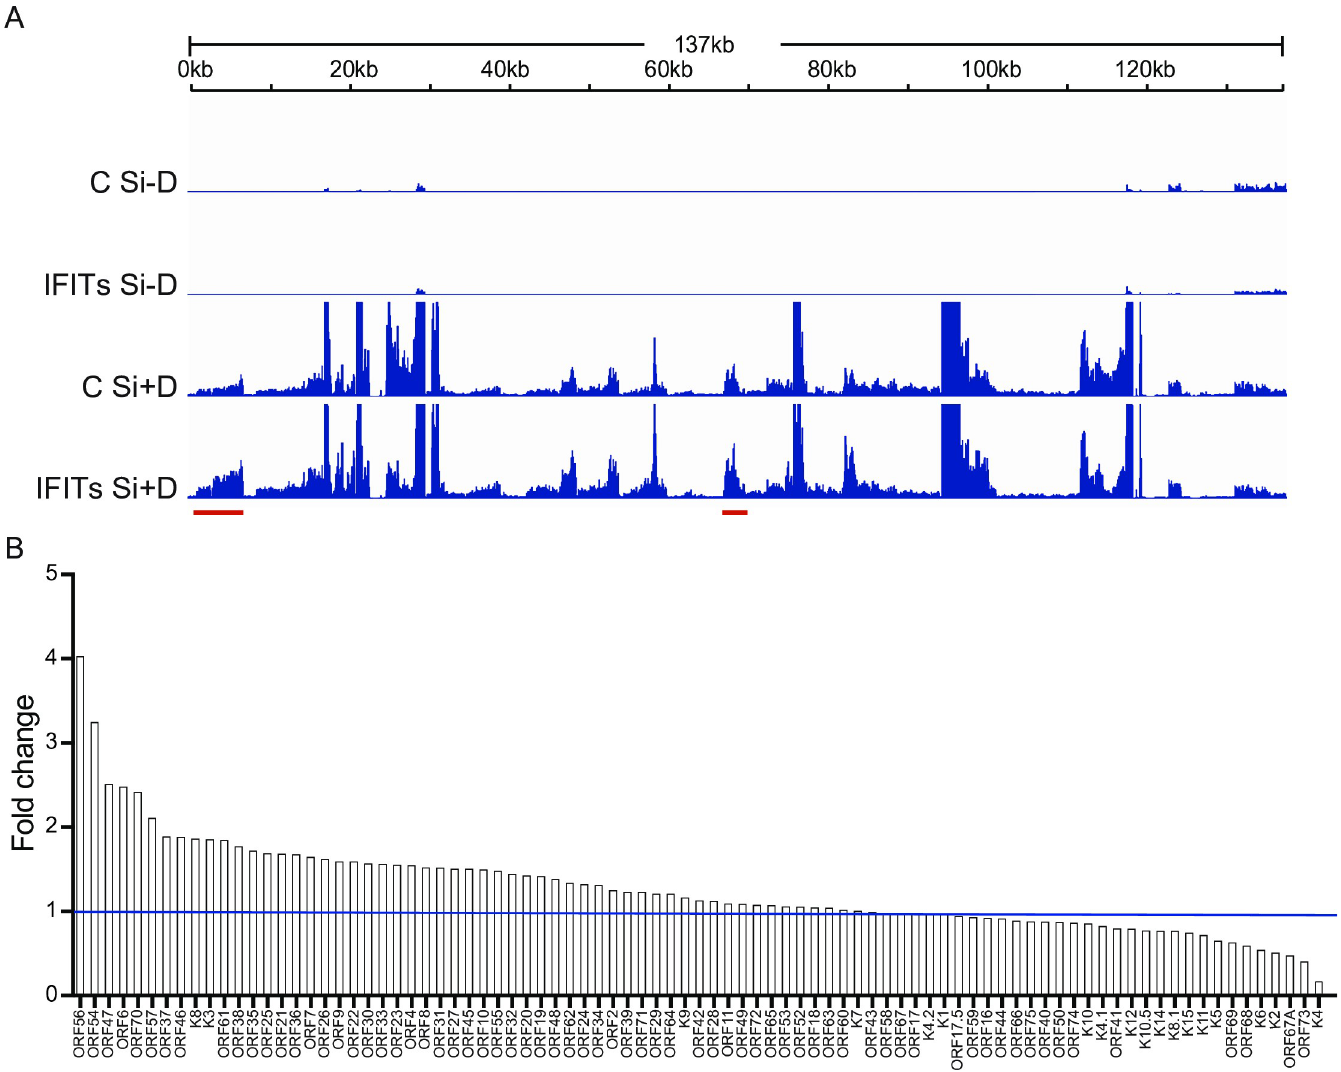
Fig 4. Effect of IFITs depletion on the KSHV lytic gene transcriptional profile defined by RNA-Seq. A. Transcriptome of KSHV in iSLK cells at 48 h after induction of lytic replication. iSLK cells were depleted of IFIT1, IFIT2 and IFIT3 (IFITs) with siRNAs or transfected with negative control siRNA. Cells were then either uninduced or induced to permit lytic KSHV replication by treatment with doxycycline. RNA was harvested at 48 hr from each sample and RNA sequencing was performed. The ratio of read number for each position on the KSHV genome in cells depleted of IFITs versus the values for corresponding control cells (NC) are shown on the y-axis and the KSHV genome position is shown on the x axis. Representative genes where IFITs knockdown led to increased transcription compared to control are marked below with red bars. B. Relative effect of IFITs depletion on KSHV mRNAs. The effect of IFITs depletion on each annotated KSHV transcript is depicted in a waterfall plot as the fold enrichment of its RNA abundance in the absence versus presence of IFITs at 48 hr after induction. Transcripts whose levels increase with IFITs knockdown are thus shown above 1 (1 marked as blue line) and transcripts that decrease in abundance with IFITs knockdown are shown below